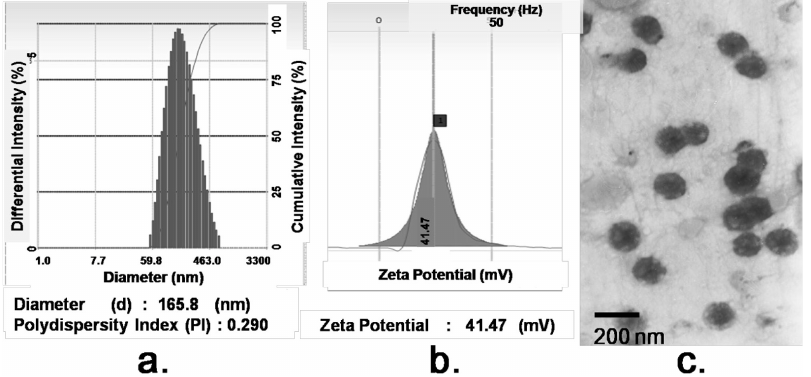
Figure 2. Characteristics of FA/PPD ( n = 3). ( a ) Particle size; ( b ) Zeta Potential; and ( c ) Transmission electron microscope (TEM)